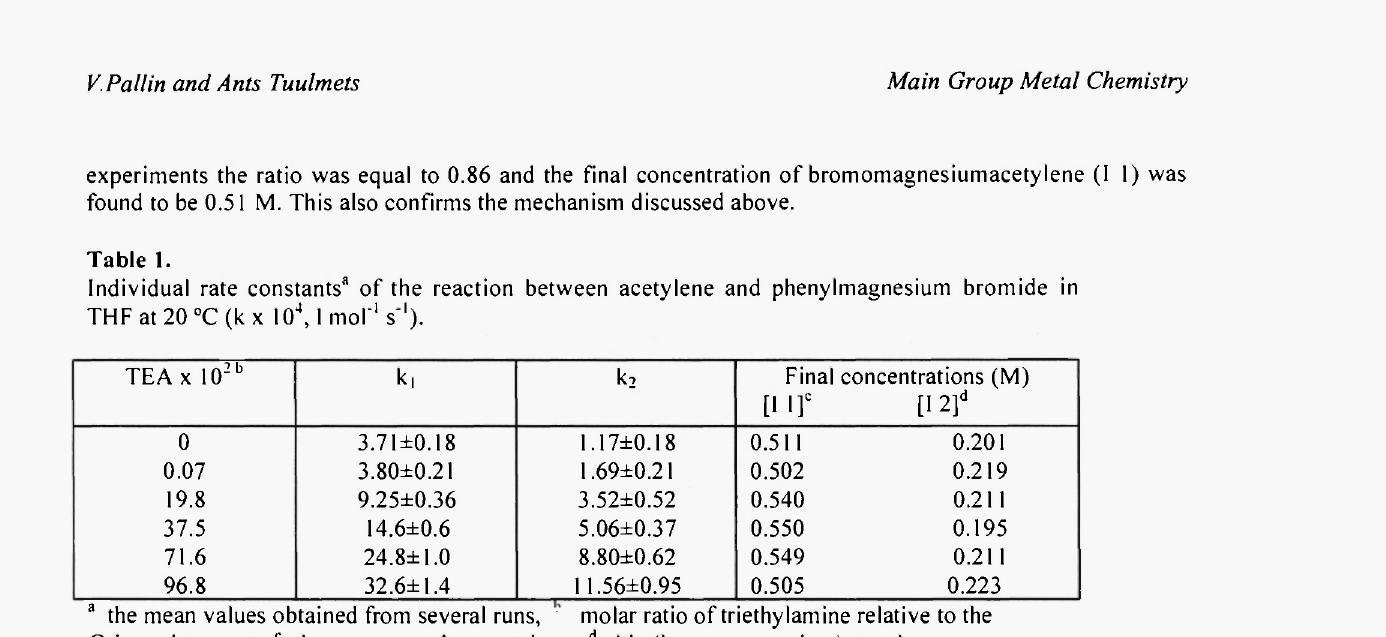
Individual rate constants 3 of the reaction between acetylene and phenylmagnesium bromide in THF at 20 °C (k χ ΙΟ 4 ,1 mol" 1 s" 1